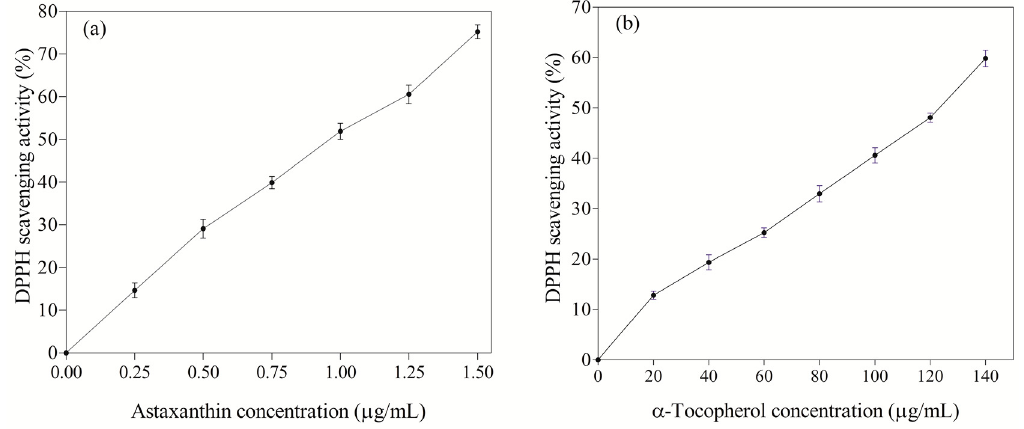
Figure 5. DPPH scavenging activity of ( a ) astaxanthin and ( b ) α -tocopherol. Table 5. DPPH scavenging activity of astaxanthin from different sources.